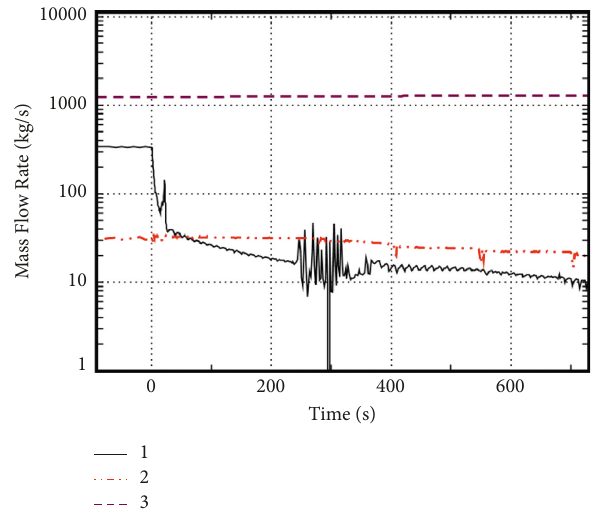
Figure 12: Change in coolant flow in the heat removal circuits from the core in case of a blackout: (1) coolant flow in the primary circuit; (2) coolant flow in the secondary circuit; (3) coolant flow in the heat transfer circuit to the final heat sink